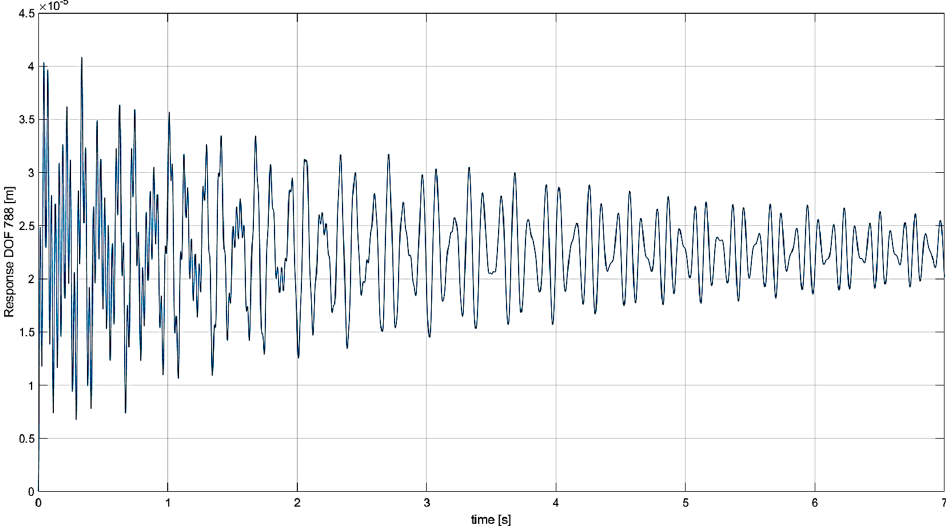
Figure 39. Nosecone deflection at Mach 0.5 with aeroelastic derivatives.